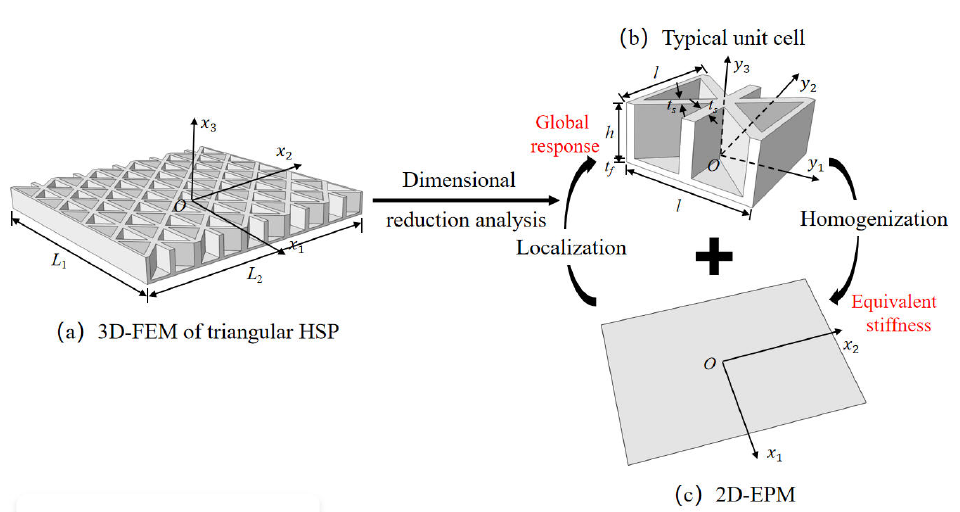
Figure 1. Analytic process of triangular HSPs by using the VAM-based equivalent model. ( a ) The 3D finite element model (3D-FEM), ( b ) constitutive modeling over the unit cell, and ( c ) 2D equivalent plate model (2D-EPM) (top facesheet removed for better